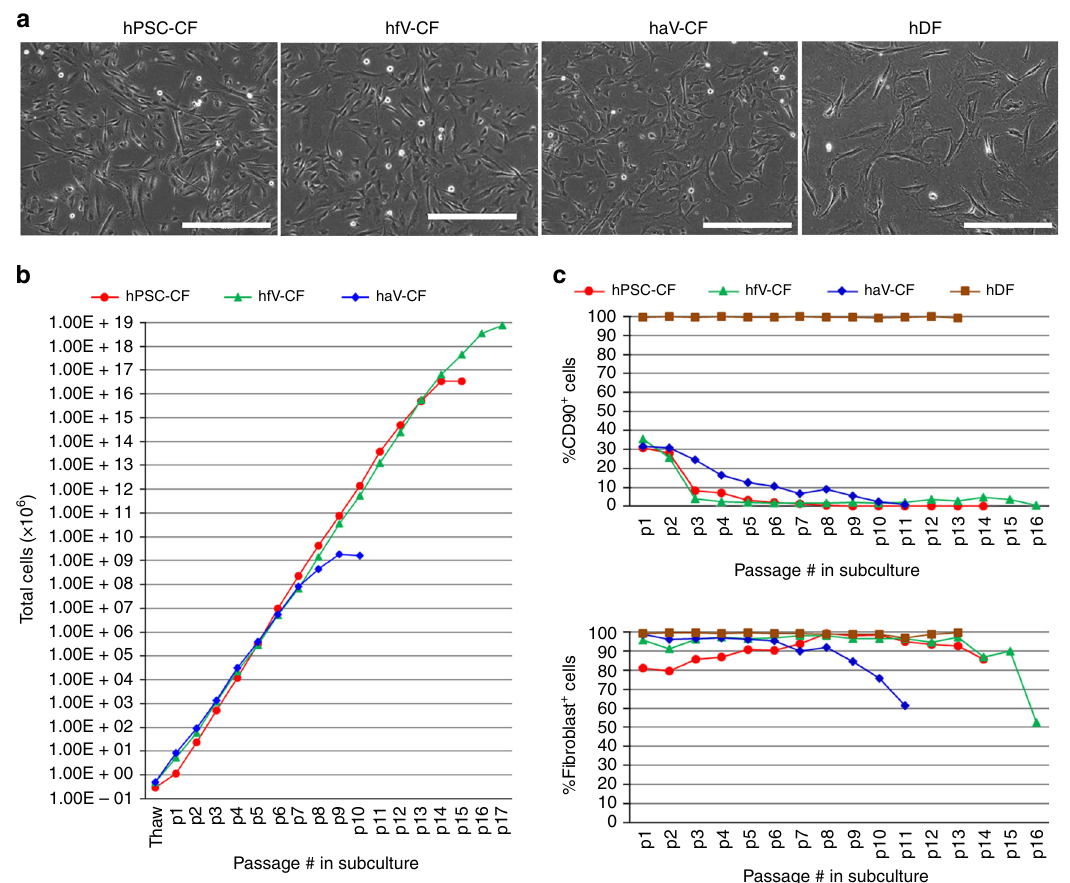
Fig. 5 Comparison of CF and DF in morphology, proliferation and marker expression. a Phase contrast images of hPSC-CFs, hfV-CFs, haV-CFs, and hDFs. b Growth capacity of hPSC-CF, hfV-CF, and haV-CF during sequential passaging. c CD90 and the human fi broblast maker (clone TE-7) expression examined by fl ow cytometry in hPSC-CFs, hfV-CF, haV-CFs, and hDFs during passaging. Scale bars are 400 μ m. The hPSC-CFs are from hiPSC line DF-19- 9-11T. The primary hfV-CFs are from Cell Applications, Inc. The haV-CFs are from Lonza, NHCF-V. The hDF line is from skin biopsies from healthy